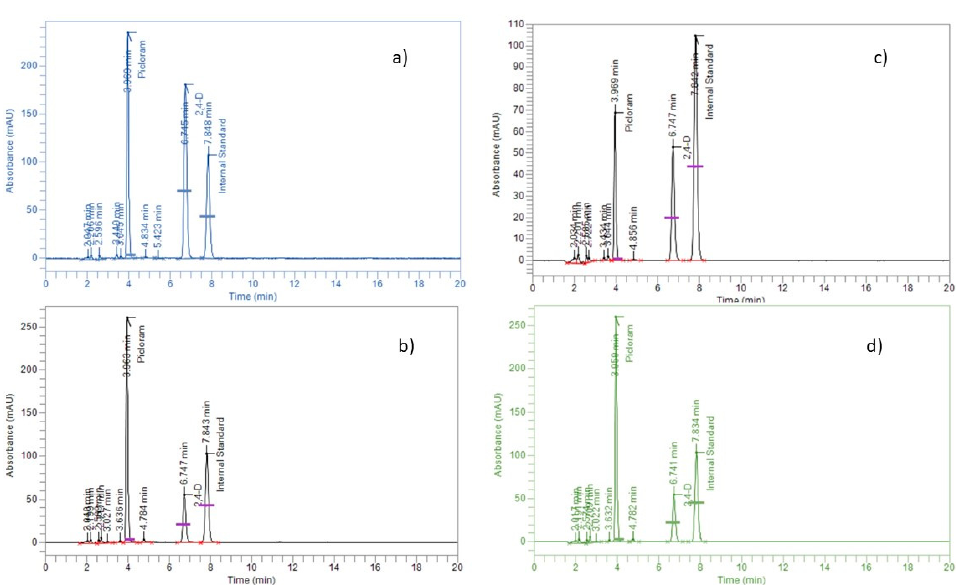
Figure 2. Chromatograms of picloram and 2,4-D determination at 235 nm: ( a ) picloram sample at concentration of 0.7 mg/mL of product corresponding to 0.025 mg/mL of picloram with propiophenone (IS) 0.025 mg/mL; ( b ) standard of picloram solution at concentration of 0.025 mg/mL with propiophenone (IS) 0.025 mg/mL; ( c ) 2,4-D sample at concentration of 0.2 mg/mL of product corresponding to 0.025 mg/mL of 2,4-D with propiophenone (IS) 0.025 mg/mL; ( d ) standard of 2,4-D solution at concentration of 0.025 mg/mL with propiophenone (IS) 0.025 mg/mL.